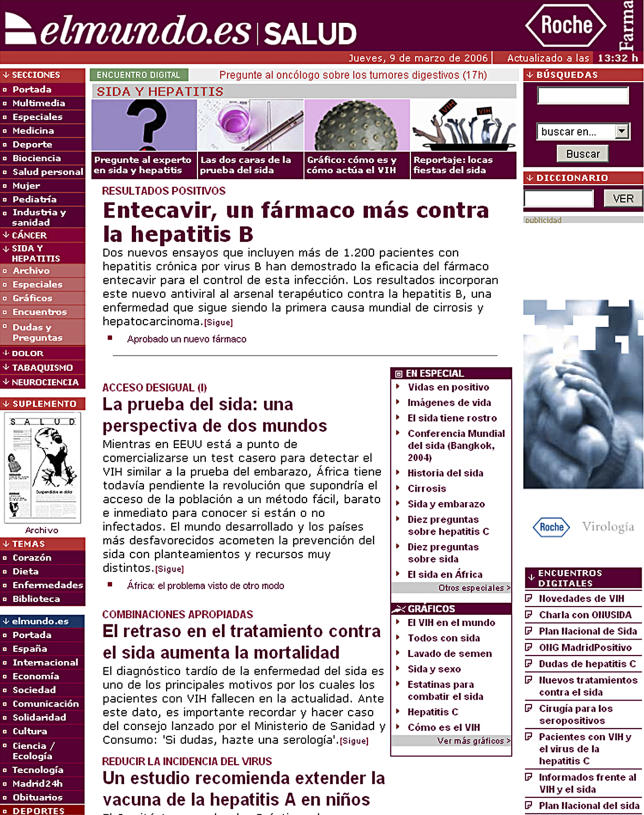
Home Page of the AIDS/Hepatitis Section